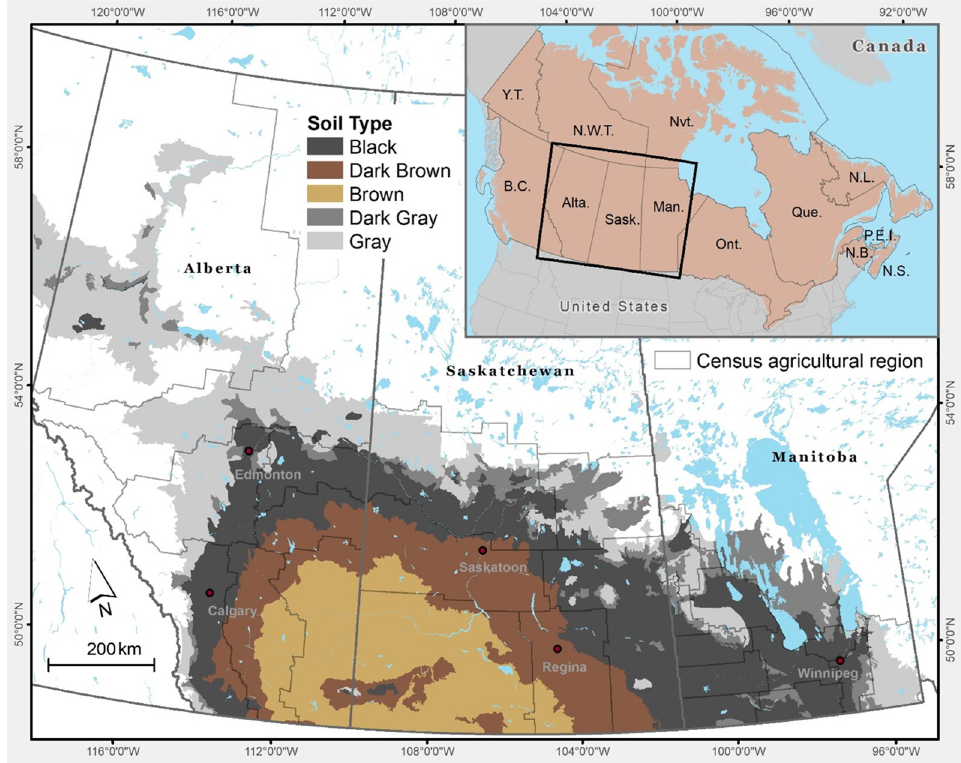
Fig 1. Distribution of major soil zones in the Canadian Prairies. Fig 1 is built at the University of Saskatchewan, Canada, using the Canadian Hub for Applied and Social Research, Mapping and Geographic Information Systems service (https://chasr.usask.ca/services/our_services/mapping-and-data-visualizations. php#MappingandGeographicInformationSystems). The main layers (Soil Zone and Census agriculture region) are downloaded from the following sites: (1) Soil zones from Prairie Soil Zones of Canada - Open Government Portal [6], and (2) Census agriculture region (filename: lcar000b16a_e) from Statistics Canada website (2016 Census Boundary files (statcan.gc.ca) [7]. The supporting layers are also downloaded from the Statistics Canada site (2016 Census Boundary files (statcan.gc.ca) [7]. All files are provided under the Statistics Canada Open Licence (Statistics Canada Open Licence (statcan.gc.ca) and Open Government Licence - Canada | Open Government, Government of Canada.